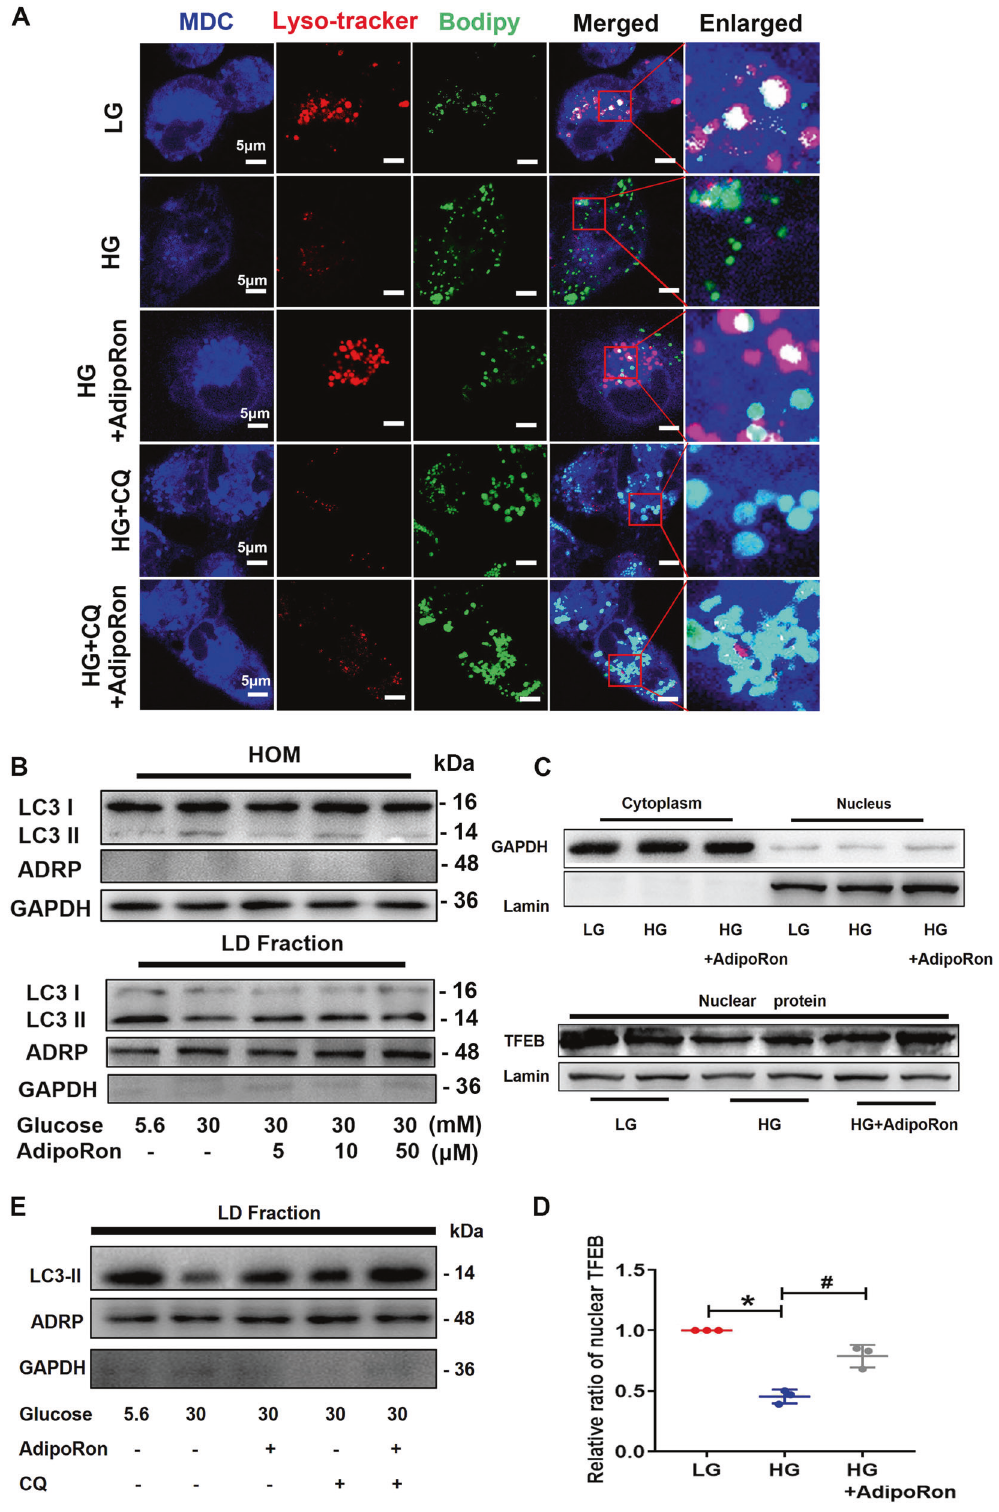
Fig. 5 AdipoRon increased lipophagy in HK-2 cells exposed to HG environment. Representative images of intracellular autophagosome (MCD), lysosomes (Lyso-tracker) and lipid (Bodipy) co-localization in HK-2 cells in an HG environment with or without AdipoRon, CQ pretreatment ( A ). WB analysis of LC3II expression using HOM and isolated LD fractions from HK-2 cells exposed to HG conditions with or without different AdipoRon concentrations ( B ). WB and densitometric analysis of TFEB expression using nuclear protein from HK-2 cells exposed to HG conditions with or without AdipoRon ( C , D ). WB analysis of LC3II expression using isolated LD fractions from HK-2 cells exposed to HG conditions with or without AdipoRon and CQ pretreatment ( E ). Values are the mean ± SD; * p < 0.05 versus LG group, # p < 0.05 versus HG group. n =